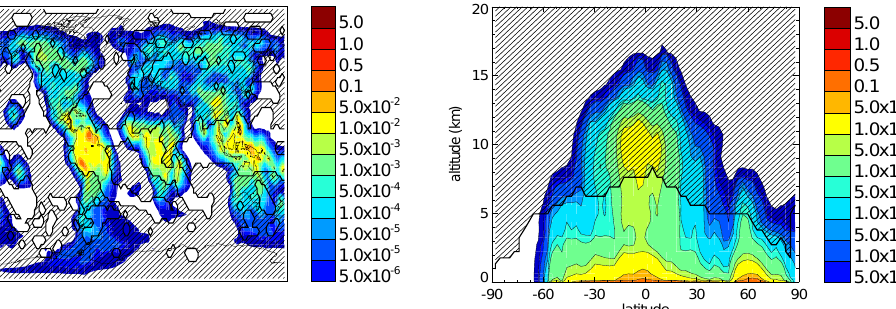
Figure 7. GLOMAP model predictions of mean annual concentrations of condensible oxidation products of monoterpenes, SORG. The concentrations shown by the colour scale are in parts per trillion with respect to mass (pptm). The hatched areas represent the zones where the SOA particles could exist in a highly viscous or amorphous phase state in the upper troposphere and potentially affect cirrus cloud formation through deposition ice nucleation or immersion freezing. The calculations for these zones are based on the theoretical estimate of generic SOA glass transition temperature as a function of relative humidity presented by Koop et al. (2011). The left panel shows a global map of the mean annual concentrations of SORG at a sigma-pressure level corresponding to approximately 6900m altitude from a simulation of the year 2000. In the right panel, annual zonal mean of global concentrations of SORG are plotted as a function of latitude and